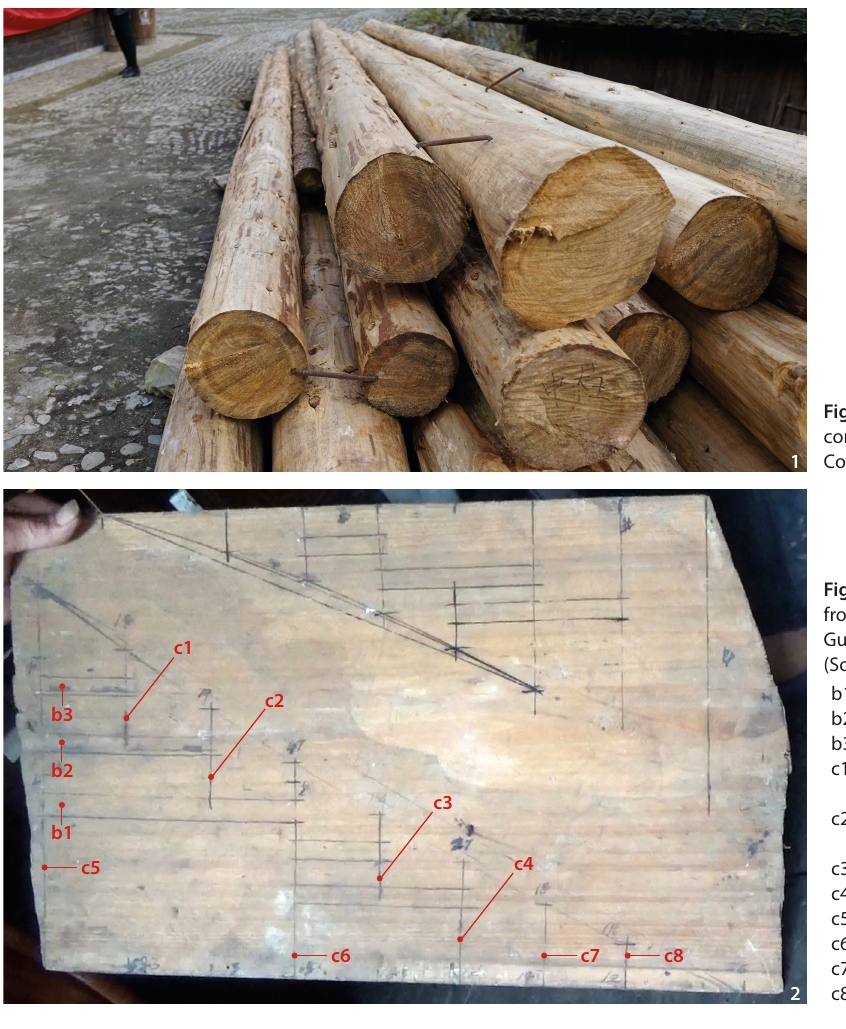
Figure 2 1:10 Section drawing, photo taken from chief carpenter Yonghua Wu’s home, Guiliu village, Rongjiang County, 2017 (Source: Ruchen Bian). b1. The first cross through beam b2. The second cross through beam b3. The third cross through beam c1. The upper ‘melon’ column in the fourth span c2. The bottom ‘melon‘ column in the fourth span c3. The upper ‘melon‘ column c4. The bottom ‘melon‘ column c5. The middle column c6. The second column c7. The eave column c8. The ‘child‘